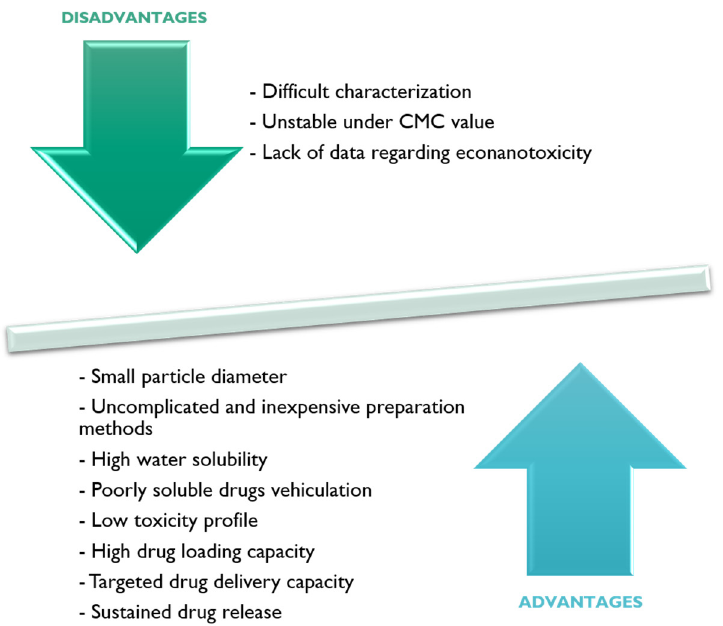
Figure 4. Summarized schematization of the principal advantages and disadvantages for PM-based carrier systems. carrier